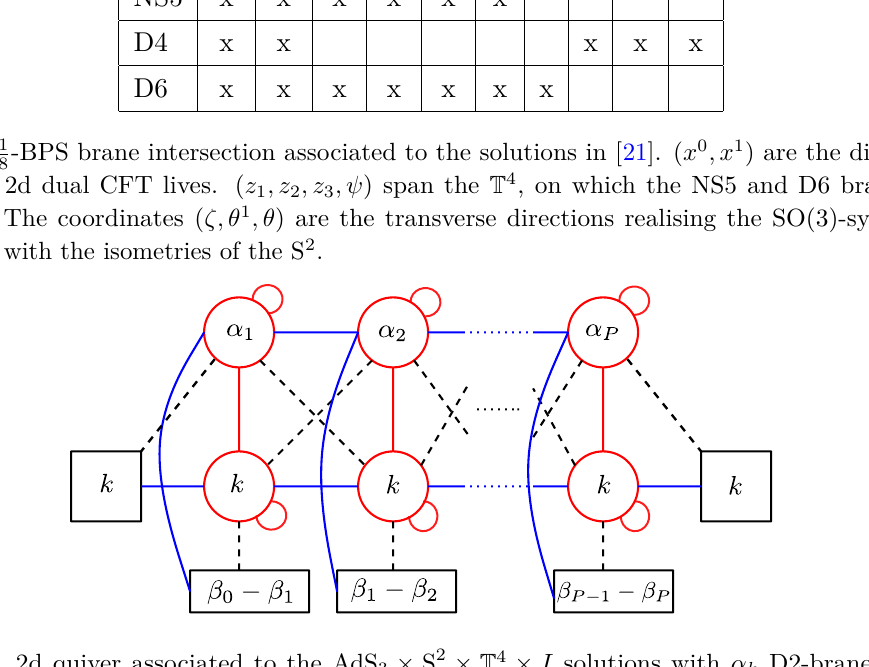
Figure 8 . 2d quiver associated to the AdS 3 × S 2 × T 4 × I solutions with α k D2-branes and k D6-branes wrapped on the T 4 . Circles denote (0 , 4) vector multiplets, blue lines (4 , 4) twisted hypermultiplets, red lines (0 , 4) hypermultiplets and dashed lines (0 , 2) Fermi